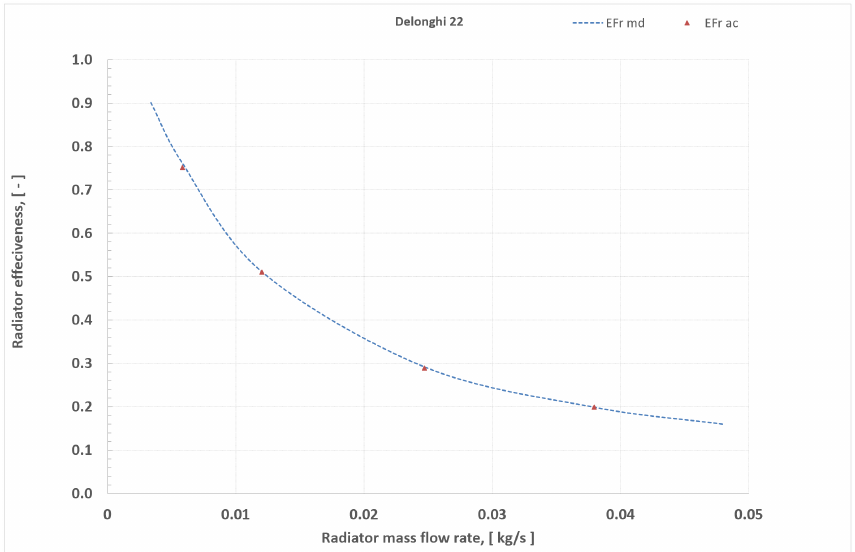
Figure 21. Comparison of measurement and calculations results of the Delonghi -22 radiator effec- tiveness, measurement 1–4 .